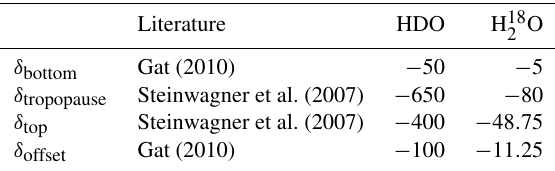
Table 1. Values for the initialization with mean measured δ values. The literature provides the values for HDO, and values for H 18 have been determined from GMWL (Craig,